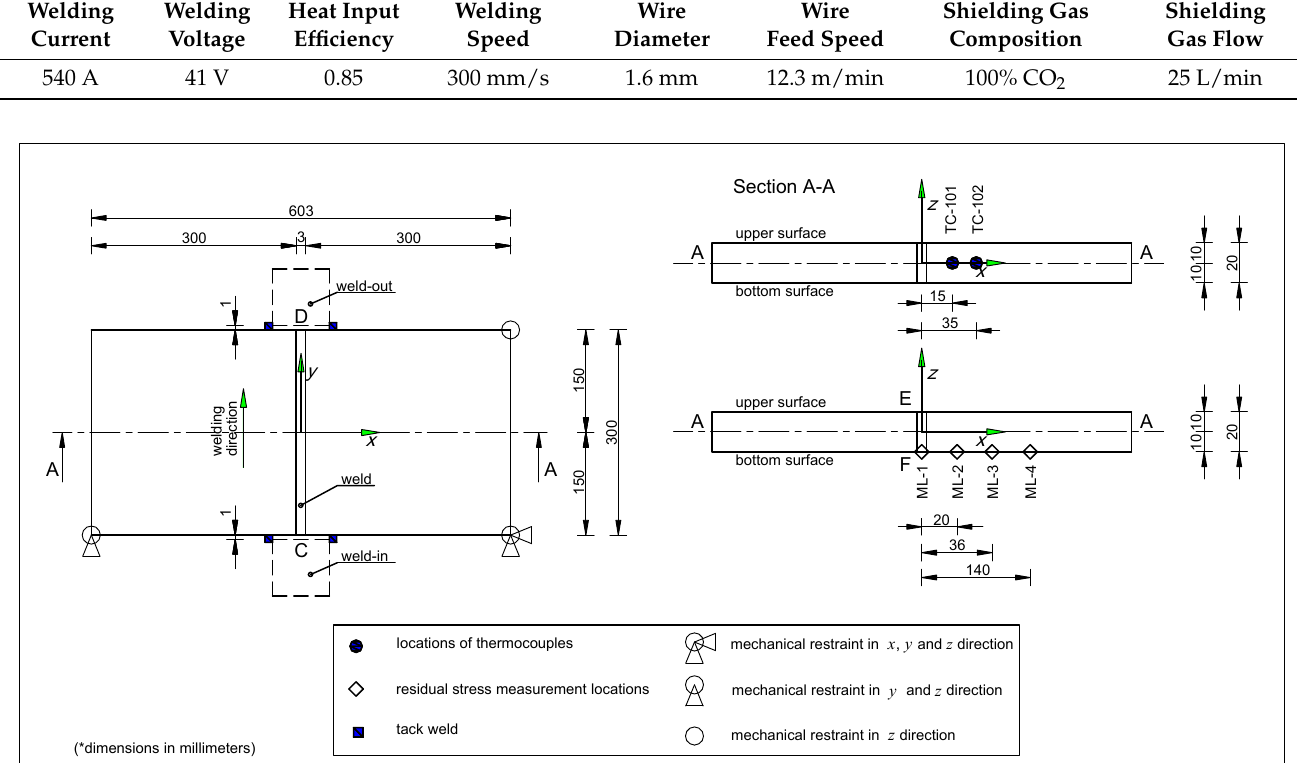
Figure 1. Geometry of the welded model.